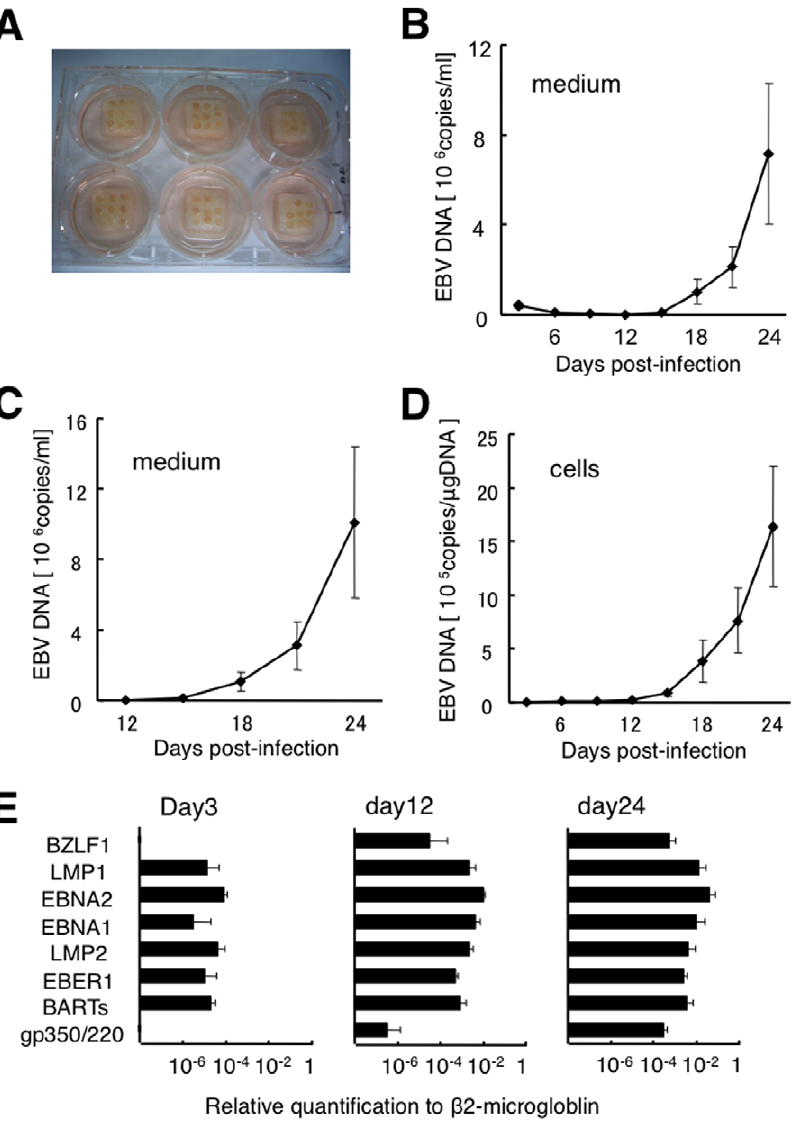
Figure 1. Kinetics of EBV DNA and expression patterns of EBV-related genes in human tonsil tissue explants infected with B95–8. Culture medium was changed every 3 days, and collected medium was centrifuged. Cell-free supernatants and cells collected from culture medium were used for quantification of EBV DNA by real-time PCR assay and quantification of viral mRNA by real-time RT-PCR assay. Data are presented as mean 6 standard error of the mean. A ) Tissue blocks on top of collagen sponge gels in a six-well plate. B ) Kinetics of EBV DNA in cell-free supernatants. Average data were obtained from tissues derived from 12 donors. C ) Plots of accumulated EBV DNA in cell-free culture medium after day 12 post-infection ( n =12). D ) Kinetics of EBV DNA in cells from medium ( n =12). E ) Levels of EBV-related gene expressions in cells at 3, 12, and 24 days post-infection ( n =4).